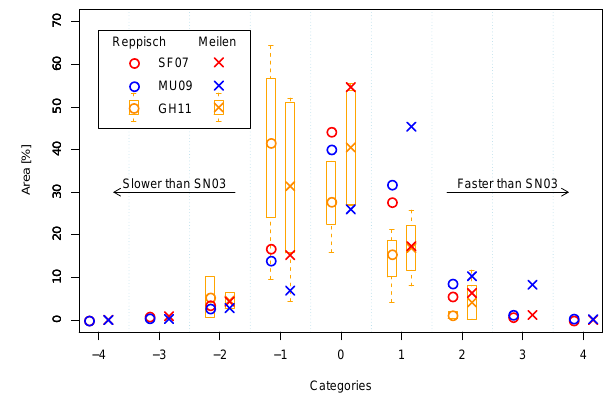
Figure 7. Distribution of the class deviations of the different auto- matic mapping approaches from the reference maps (circles refer to the Reppisch catchment and crosses to the Meilen catchment). The boxplots show median and interquartile ranges from the comparison between GH11 maps and the reclassified reference maps.